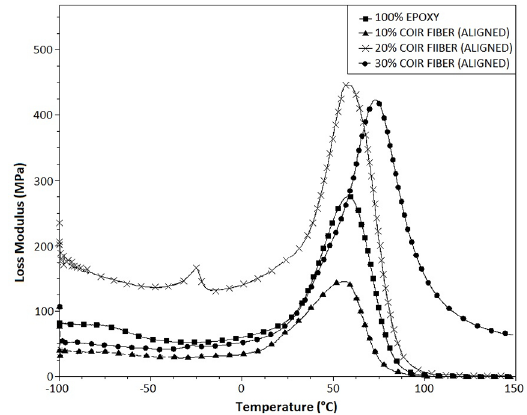
Figure 3. The variation of loss modulus as a function of temperature for the different composites.